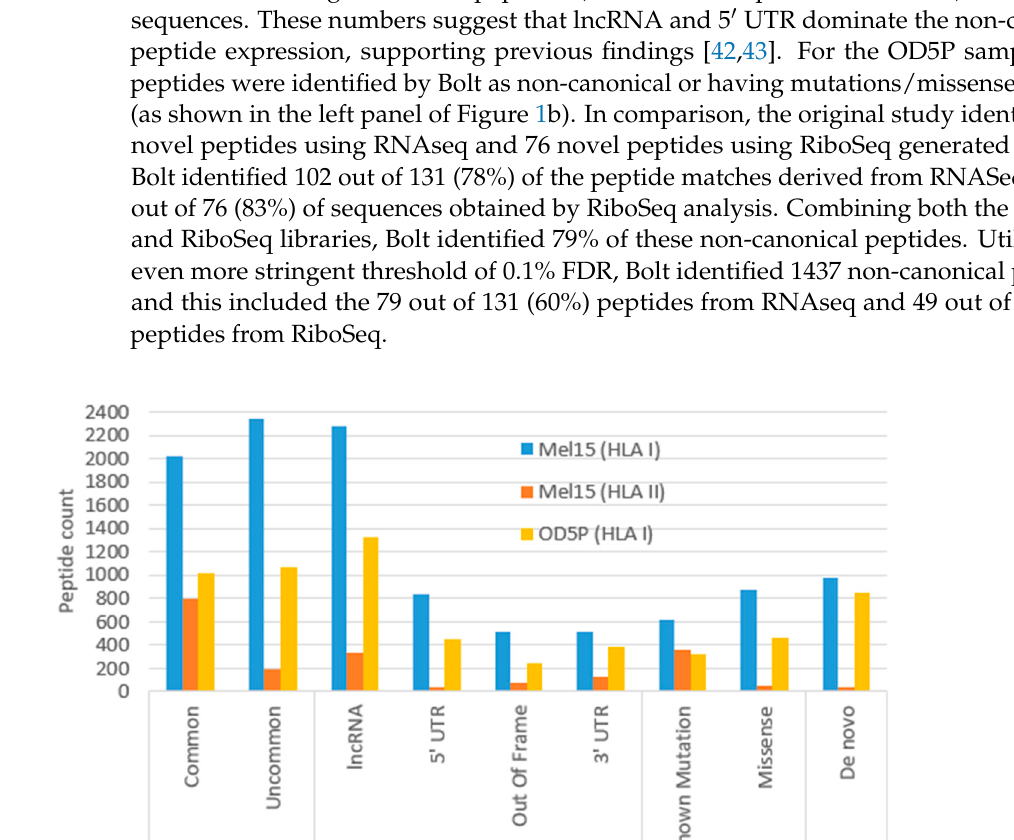
Figure 1. Non-canonical identifications by Bolt in the Mel15 and OD5P data sets. (a) Counts of var- ious types of unique identifications in the ultra large database search. Identifications are categorized into four categories: peptides with modifications (common and uncommon), peptides from non- canonical origins, variant peptides (known and all possible missense), and de novo sequences. ( b ) Left pie chart shows the predicted neoantigens from Bolt’s results for the OD5P data set and its intersection with RNAseq and RiboSeq results. Right pie chart shows the predicted neoantigens from Bolt’s results for Mel15 data set (HLA I) and its intersection with ExonSeq results. 3.4. Identification of Variants The original study on the Mel15 data set also utilized exome sequencing to perform stringent somatic single nucleotide variant calling, followed by creating a patient-specific custom database. This analysis identified five additional peptides with sequence variants derived from these results at a 1% peptide level FDR. As shown in the right pie chart of Figure 1b, in Bolt’s ultra large database search where all possible missense variants were considered, 1497 missense variants were identified, including the five that were reported by the original study (Table S1). In total, Bolt identified 6605 non-canonical peptides. With